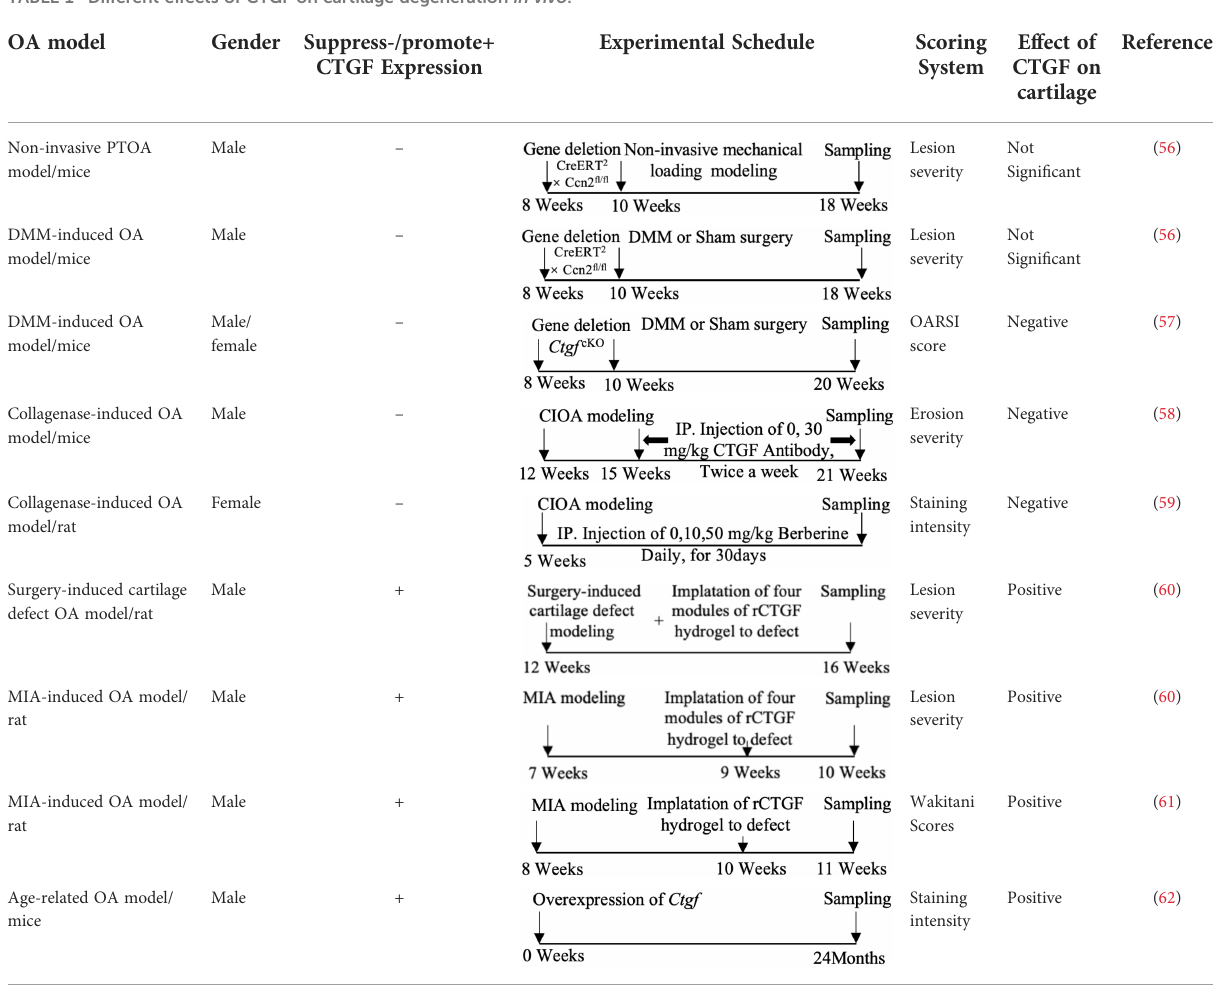
TABLE 1 Different effects of CTGF on cartilage degeneration in vivo